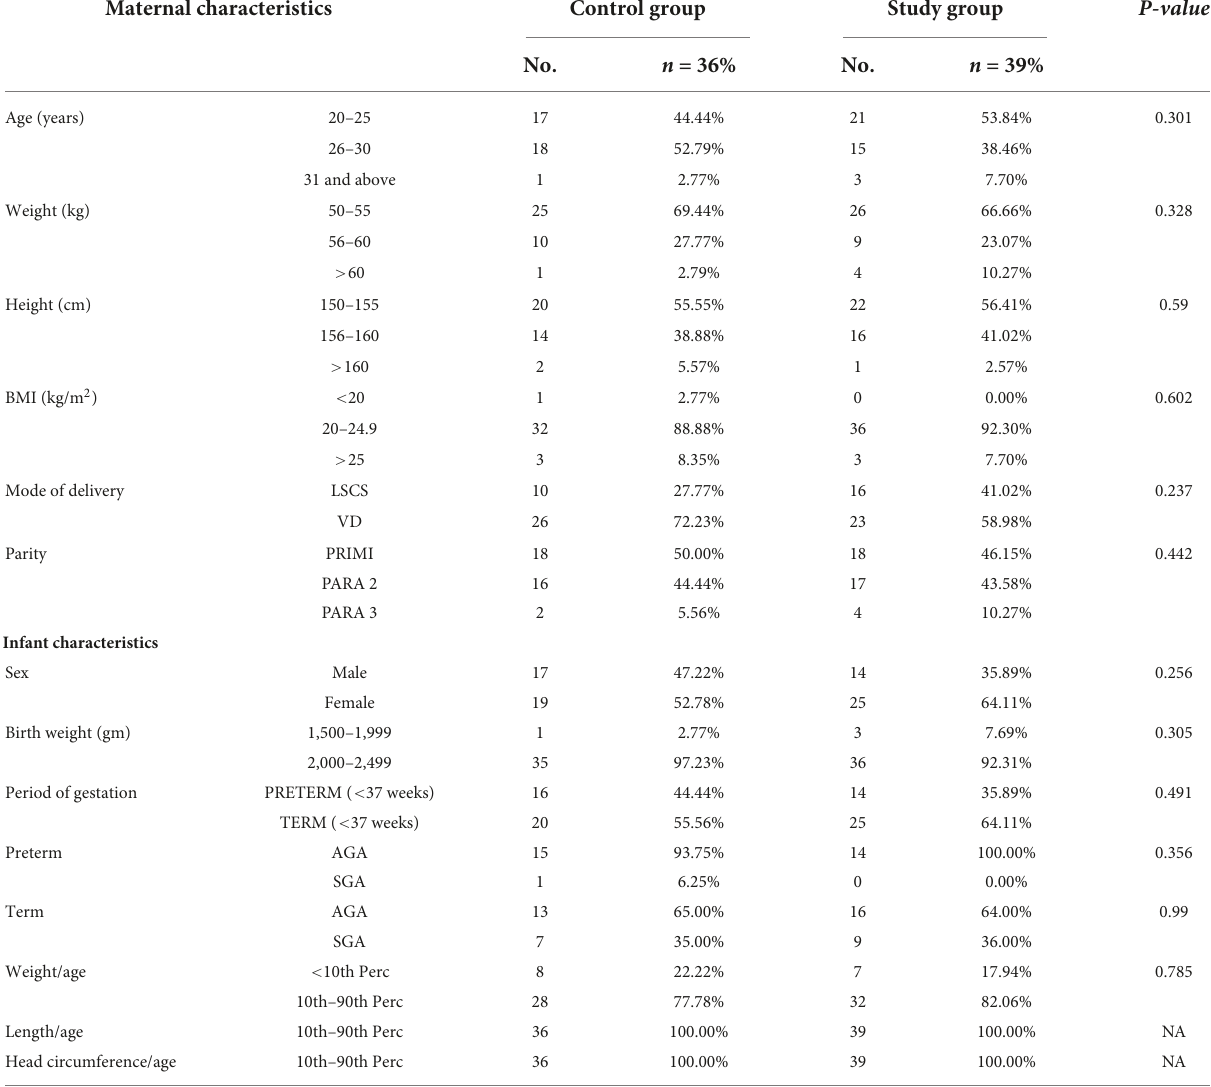
TABLE 1 Baseline characteristics of mothers and infants at